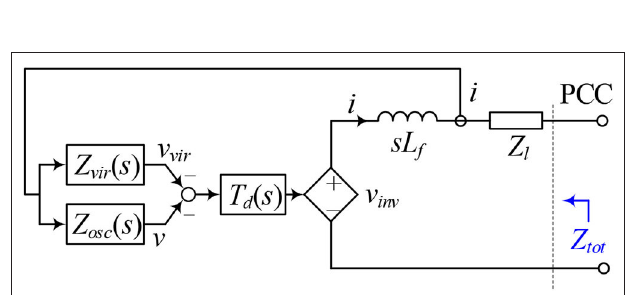
FIGURE 17 | Impedance model of VOC with virtual impedance control.